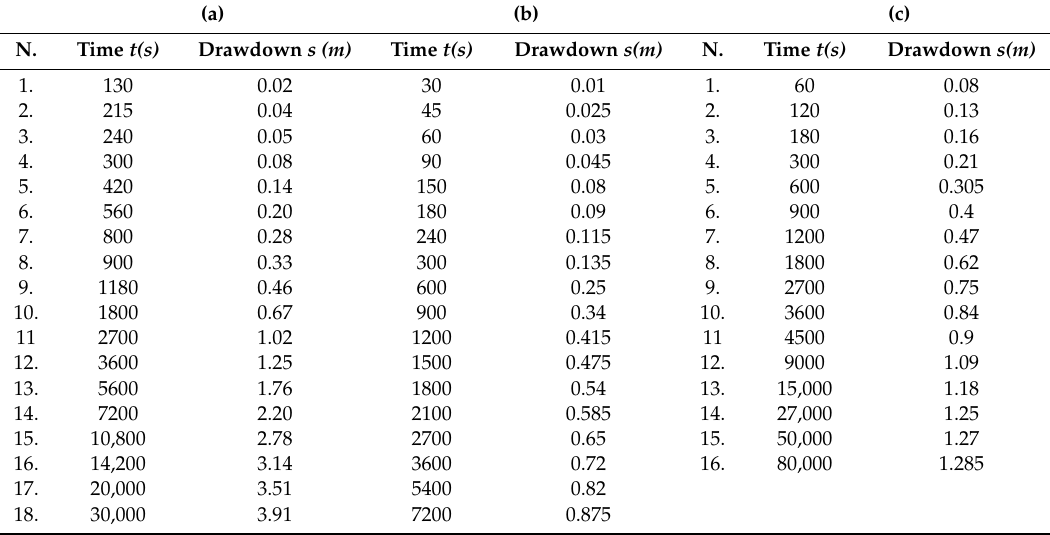
Table 3. Pumping tests at S-V well in Vesel í nad Lužnic í before rehabilitation (a), after rehabilitation (b), and one year after rehabilitation